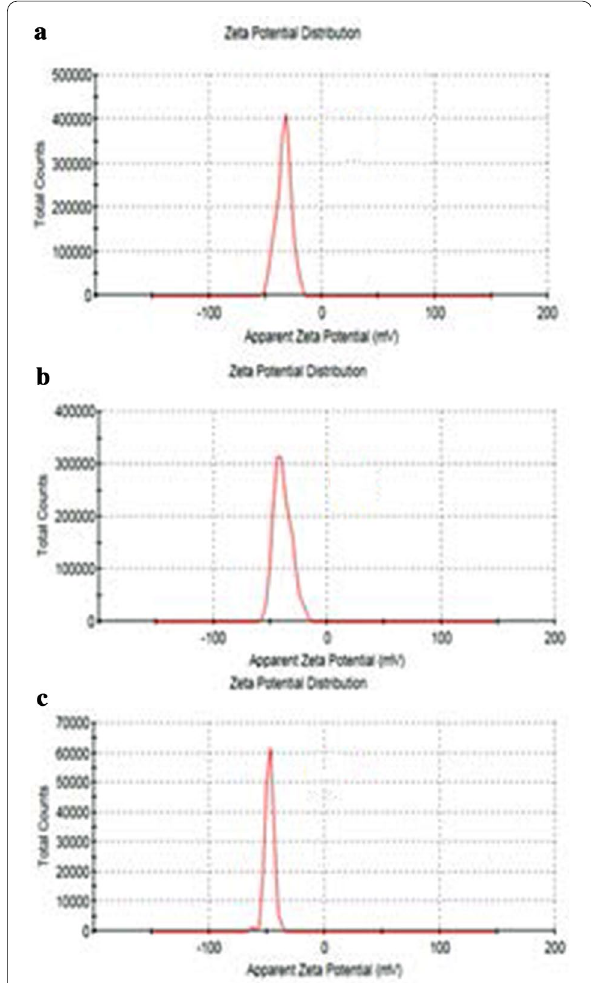
Fig. 5 Zeta potentials of GO ( a ), Tau-GO ( b ), and 5-FU-Tau-GO ( c